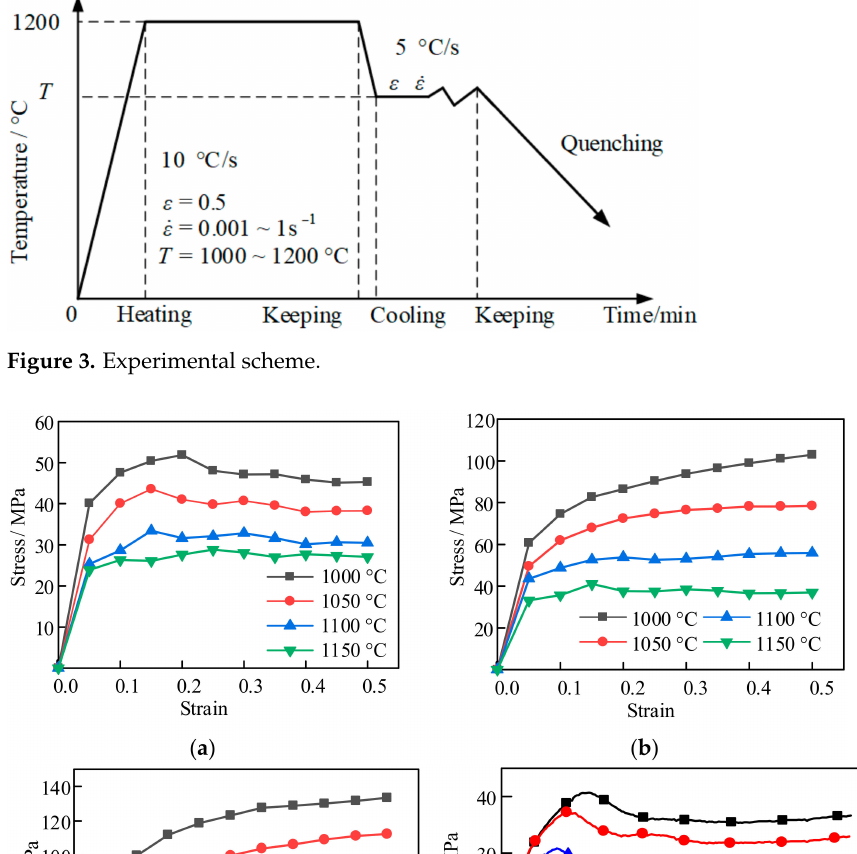
· ε = 0.01 s − 1 ; ( c ) common cylindrical specimen at · · ε = 0.01 s − 1 ; ( f ) SCS at ε = 0.1 s − 1